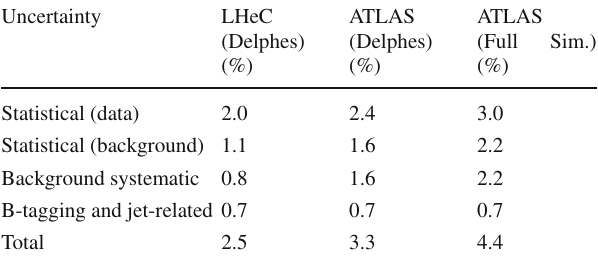
Table 5 Calculation of the expected uncertainties on the cross section for a given number of signal and background event in the different scenarios